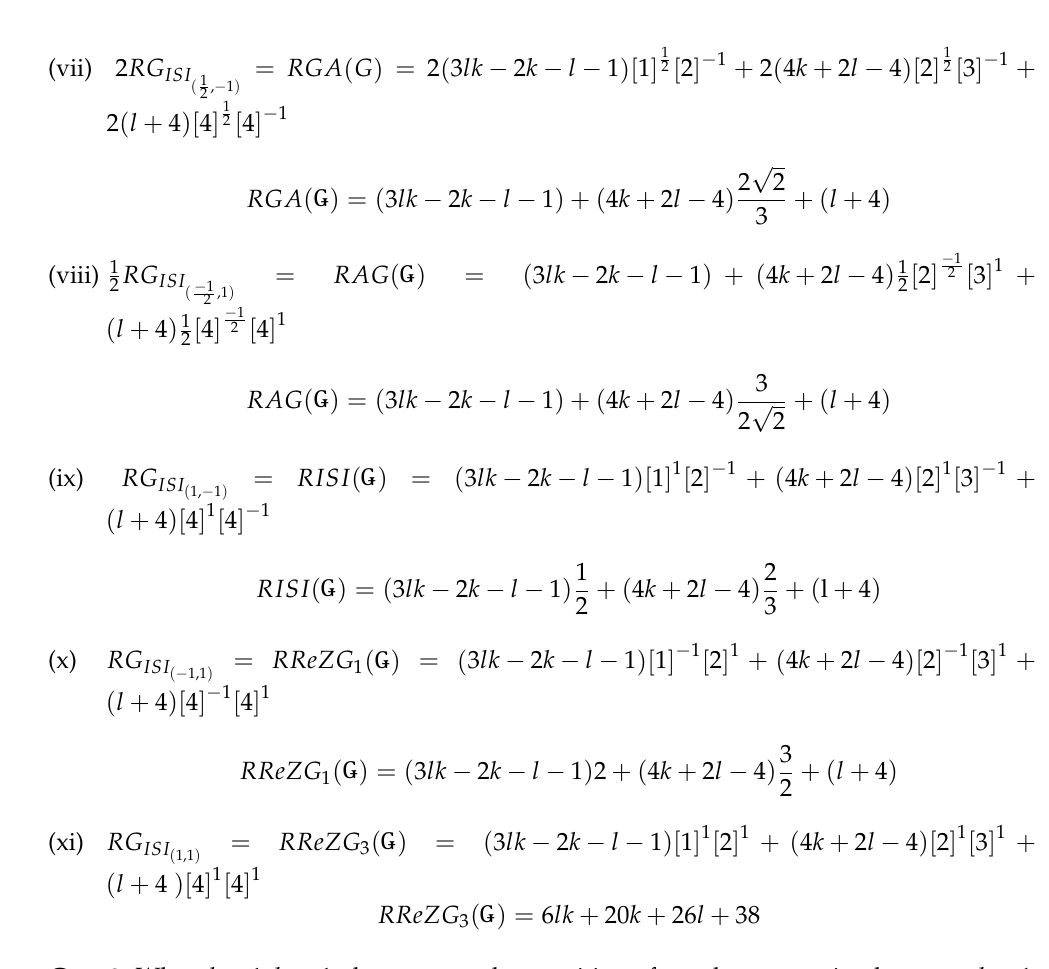
Table 1. Some reverse degree-based topological descriptors derived from the reverse general inverse sum indeg descriptor by assigning specific values to the parameters 𝑝 and 𝑞 .